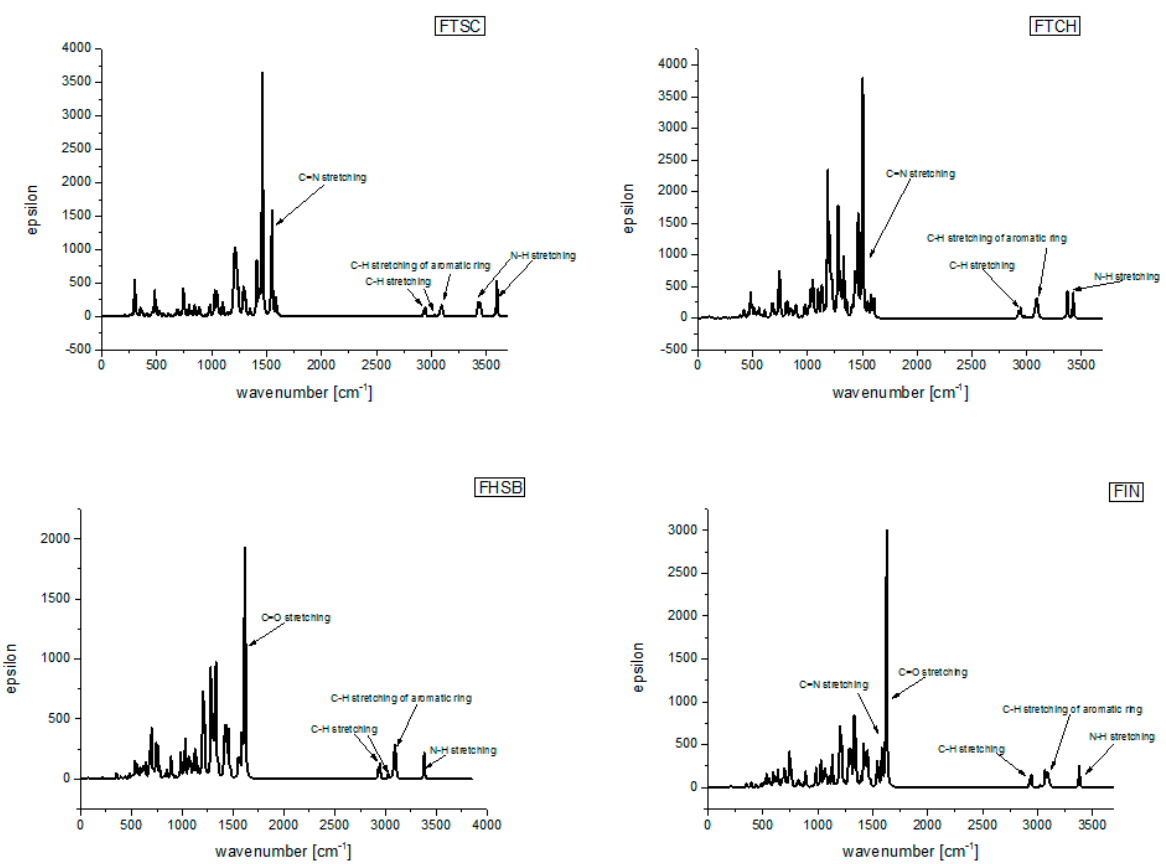
Figure 3. Theoretically predicted (at the density functional theory (DFT)(B3LYP)/6-31+G(d,p)/PCM(DMSO) level of theory) infra-red (IR) spectra of the studied compounds. Table 1. The DFT (B3LYP)/6-31+G(d,p)/PCM(DMSO) calculated vibrational frequencies together with their experimental values.